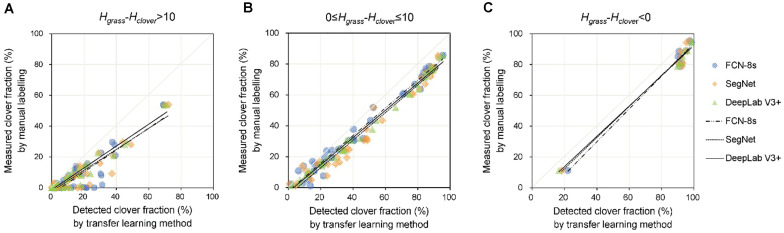
Comparison of transfer learning models [DeepLab V3+, SegNet, and fully convolutional network-8s (FCN-8s)] used to estimate the clover fraction, sorted by different relationships between clover and grass height. (A)
Hgrass – Hclover > 10 cm. (B) 0 cm ≤ Hgrass – Hclover ≤ 10 cm. (C)
Hgrass – Hclover < 0 cm. Hgrass represents the average grass height (cm) in a mixed clover–grass sample sward, and Hclover represents the average clover height (cm).